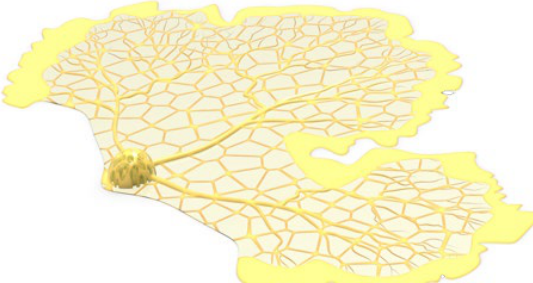
Figure 4 | Model of Physarum polycephalum ‘s network of single- celled organisms, Cesar & Lois and DaTA Lab,